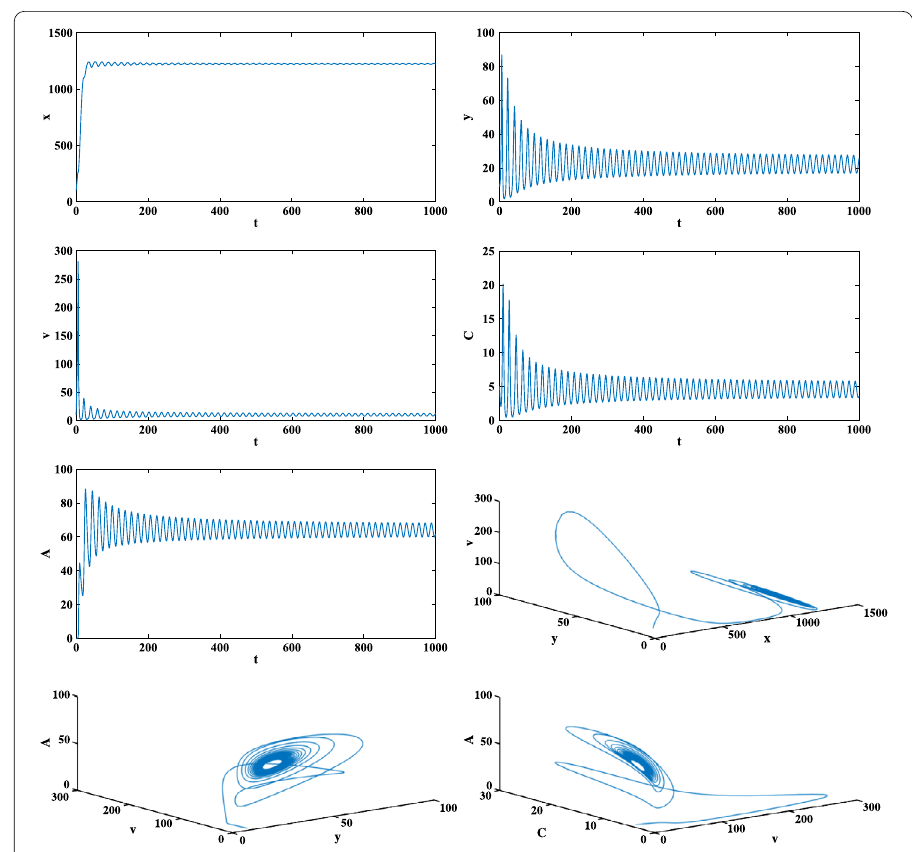
Figure 2 The phase diagrams of system (2) undergoing Hopf bifurcation when τ = 1.2